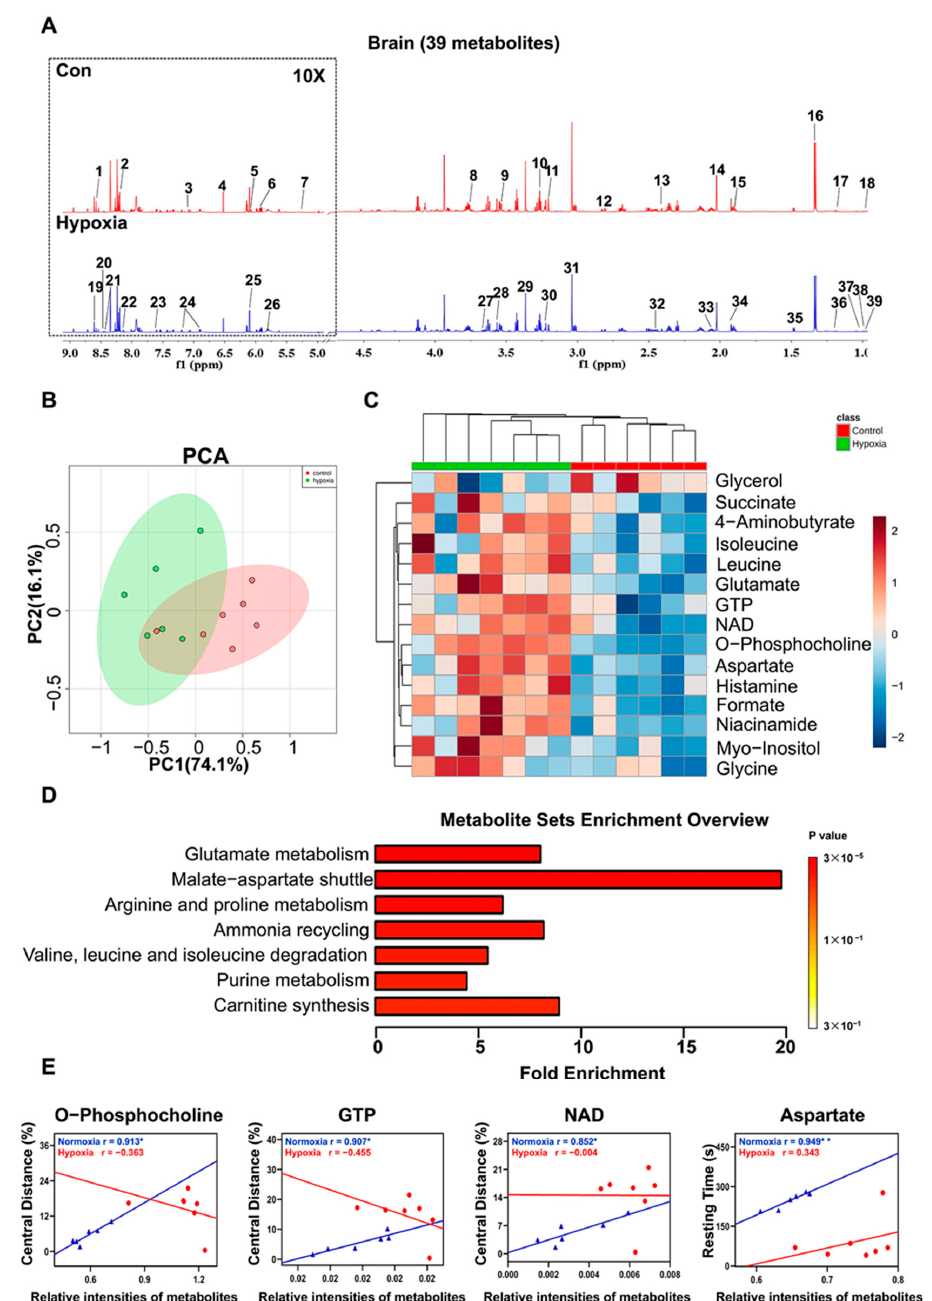
Figure 6. Metabolomic analysis of the brain. ( A ) Representative 1D 1 H NMR spectra of aqueous extracts derived from the brain of mice. 1, Inosinic acid; 2, Adenine; 3, Histamine; 4, Fumarate; 5, Adenosine; 6, Uridine; 7, Glucose; 8, Ascorbate; 9, Myo-inositol; 10, Taurine; 11, O-Phosphocholine; 12, Aspartate; 13, Succinate; 14, N-Acetylaspartate; 15, 4-Aminobutyrate; 16, Lactate; 17, Ethanol; 18, 3-Hydroxyisobutyrate; 19, Adenosine monophosphate; 20, Formate; 21, Nicotinamide adenine dinucleotide; 22, Guanosine triphosphate; 23, Niacinamide; 24, Tyrosine; 25, Inosine; 26, Uracil; 27, Glycerol; 28, Glycine; 29, Caffeine; 30, Glycerophosphocholine; 31, Creatine phosphate; 32, Glutamine; 33, Glutamate; 34, Acetate; 35, Alanine; 36, 3-Hydroxyisobutyrate; 37, Valine; 38, Leucine; 39, Isoleucine. ( B ) PCA score plot, illustrating the distinct metabolic difference between hypoxic mice and controls. The x -axis represents the first PC accounting for 74.1% of the total variation, and the y -axis denotes the second PC accounting for 16.1% of the total variation. Ovals in the panel highlight the metabolic distinction between two groups. ( C ) Clustered heatmap plot of relative metabolite levels, showing metabolic derangement. ( D ) Significantly altered metabolic pathways. ( E ) The correlations of relative intensities of metabolites with mice performances in the open field test. *, p <